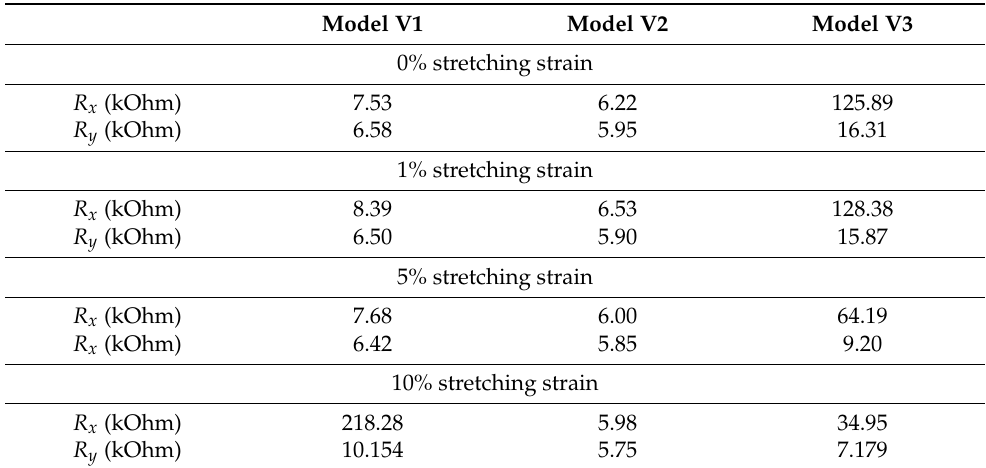
Table 2. Electrical resistance values of hybrid graphene/SWCNT (12, 6) films under axial stretching. Model